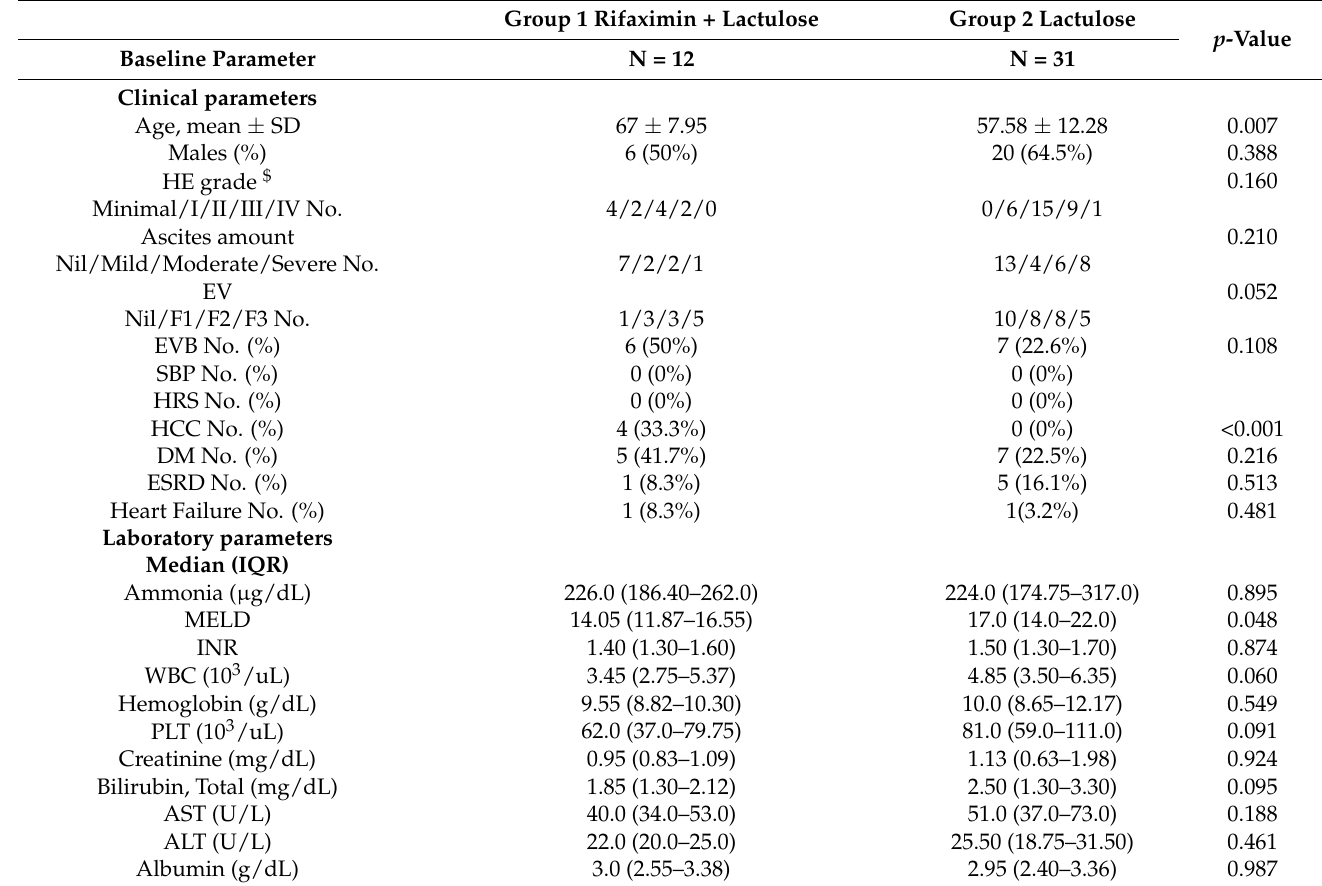
Table 1. Demography and baseline clinical characteristics of group 1 and group 2